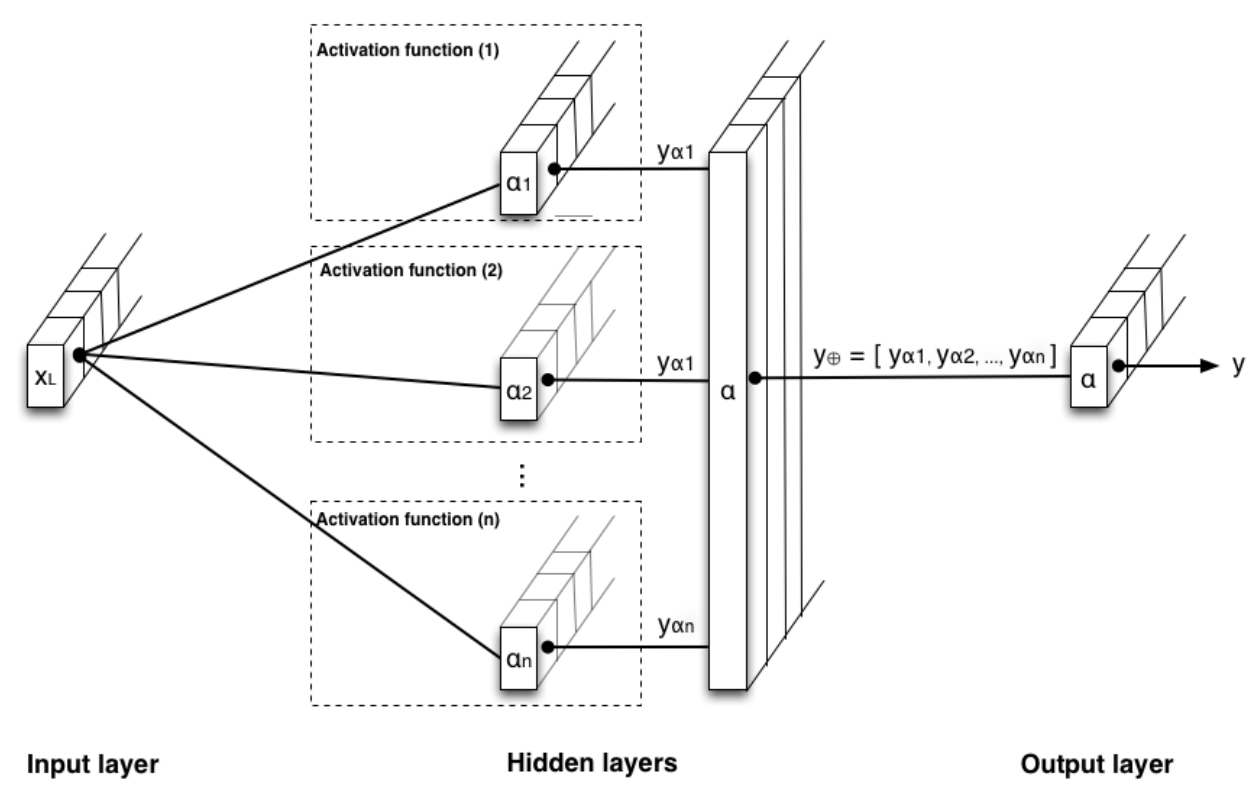
Figure 3. Graphic representation of the activation function fusion proposed in this method. Where X data retrieved, α stands for the activation functions, y depicts the activation functions’ outcome and y ⊕ its